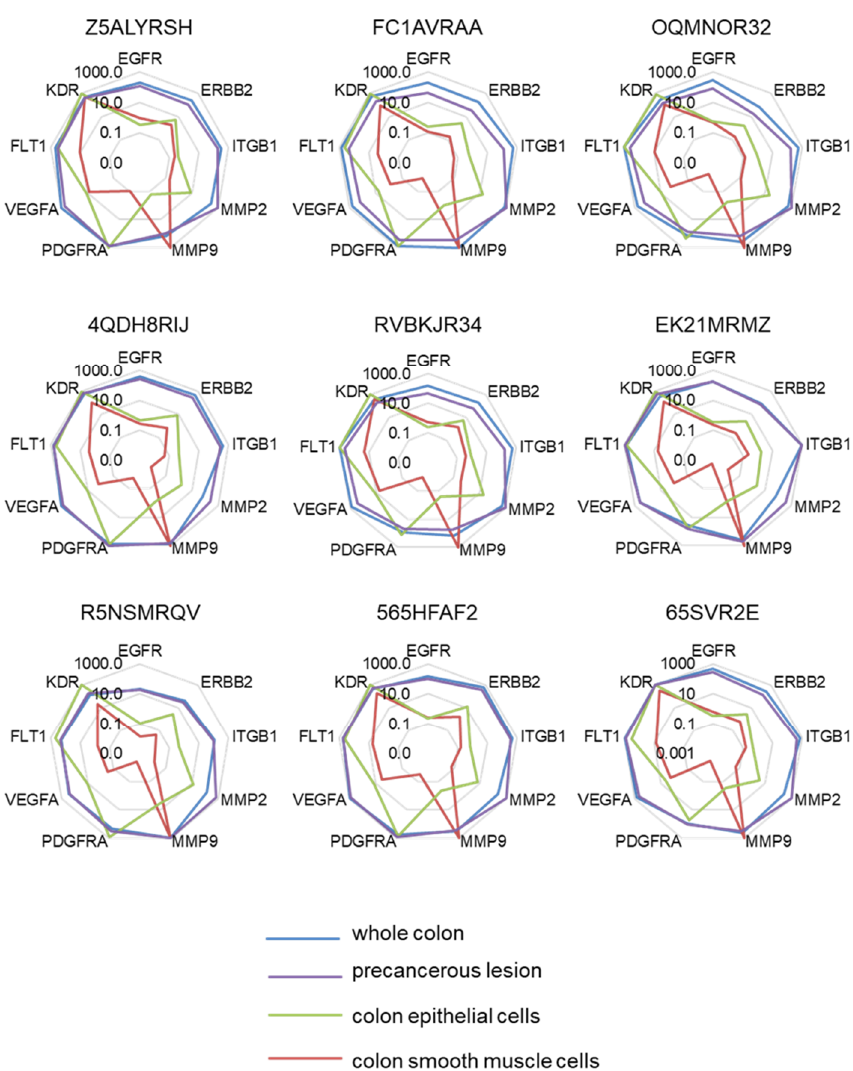
Figure 2. Molecular signatures after single normalization. The different radar graphs are showing the molecular signature of each tumor sample when expression data were expressed according to comparisons (2 −ΔΔCt ) with whole normal colon (blue line), precancerous lesion (purple line), colon epithelial cells (green line), or colon smooth muscle cells (red line).